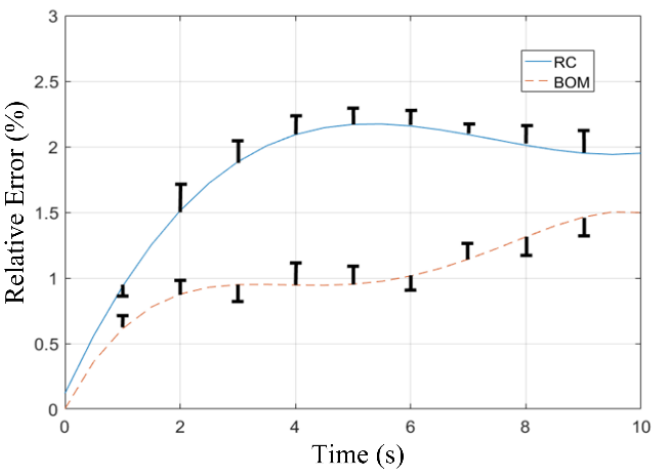
Figure 12. Relative error analysis results of the manipulator with a traditional rigid connection plate (RC) and a flexible connection plate (BOM) in the process of moving.